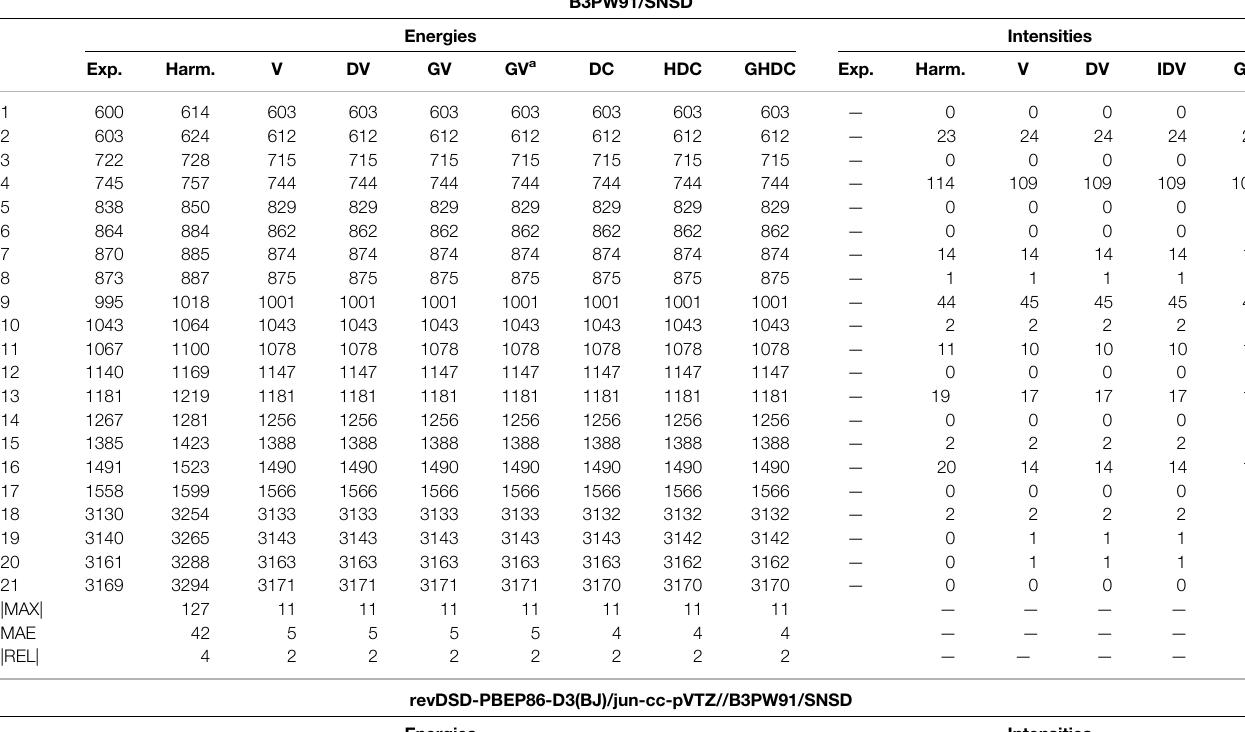
TABLE 5 | Harmonic and anharmonic vibrational energies (in cm − 1 ) and intensities (km/mol) of furan computed at the B3PW91/SNSD and hybrid revDSD-PBEP86-D3(BJ)/ jun-cc-pVTZ//B3PW91/SNSDlevelsoftheoryandwithdifferentVPT2schemes.Themaximum(|MAX|)andmean(MAE)absoluteerrors,aswellasthemaximumrelative error weighted by the reference value (|REL|, given in %) are reported with respect to experimental data from (Mellouki et al., 2001). B3PW91/SNSD Energies Intensities